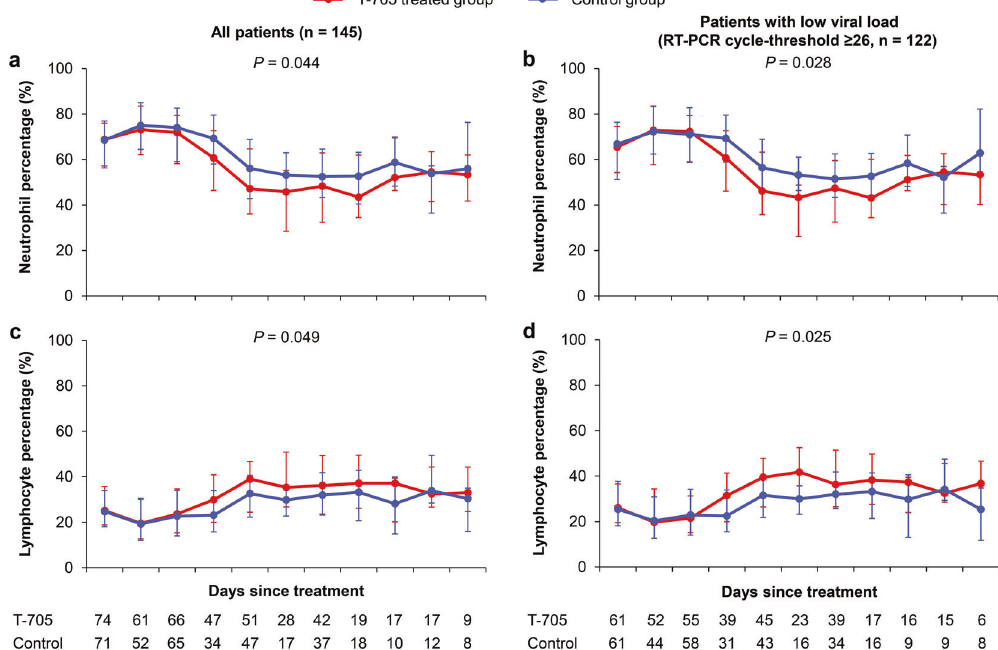
Fig. 7 The kinetics of key laboratory parameters in the patients. The median (quartile range) values of neutrophil percentage and lymphocyte percentage are shown over time for all the patients ( n = 145, a and c ), and the patients ( n = 122, b and d ) with low-baseline viral loads (RT-PCR cycle-threshold value ≥ 26). The numbers of patients who contributed to the at-risk population at each time point are shown under the x axis. The difference of these severe complications was analyzed over time (the curves) by using the generalized estimating equation model Signal Transduction and Targeted Therapy (2021)